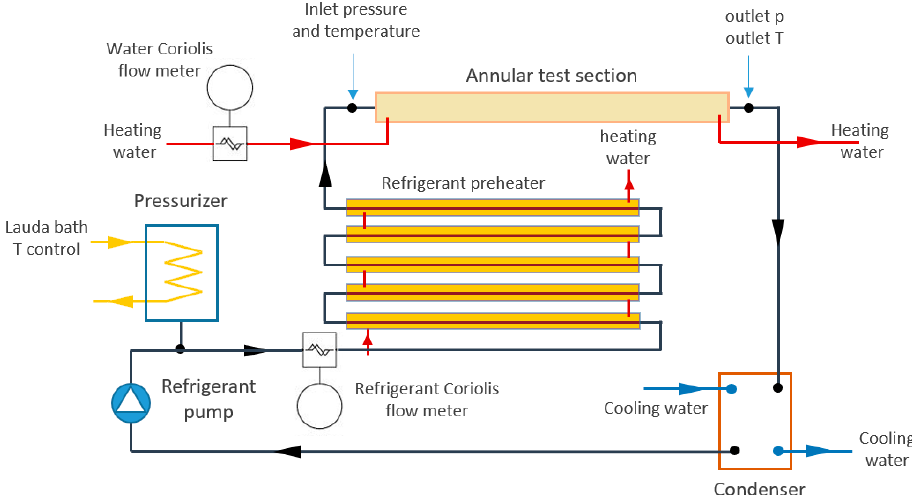
Figure 3. Schematic of the experimental loop with refrigerant loop (black) and adjacent heating loop (red), cooling loop (blue) and pressurizer loop with Lauda bath (yellow).